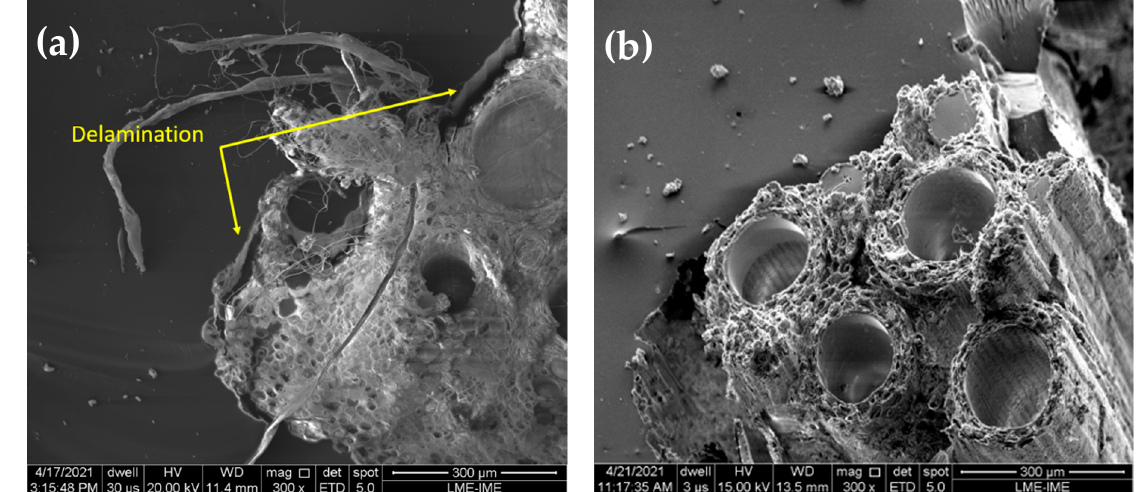
Figure 13. SEM of fracture surface of composites incorporated with untreated TVFs after Izod impact test: ( a ) 30 vol% TVF; and ( b ) 40 vol% TVF.